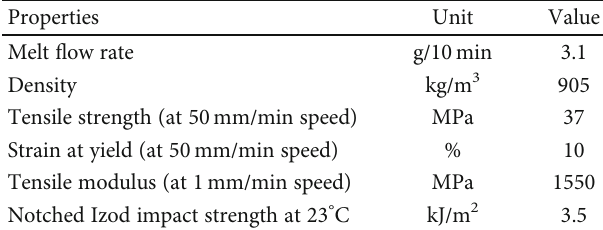
Table 1: Properties of polypropylene (data from the manufacturer).